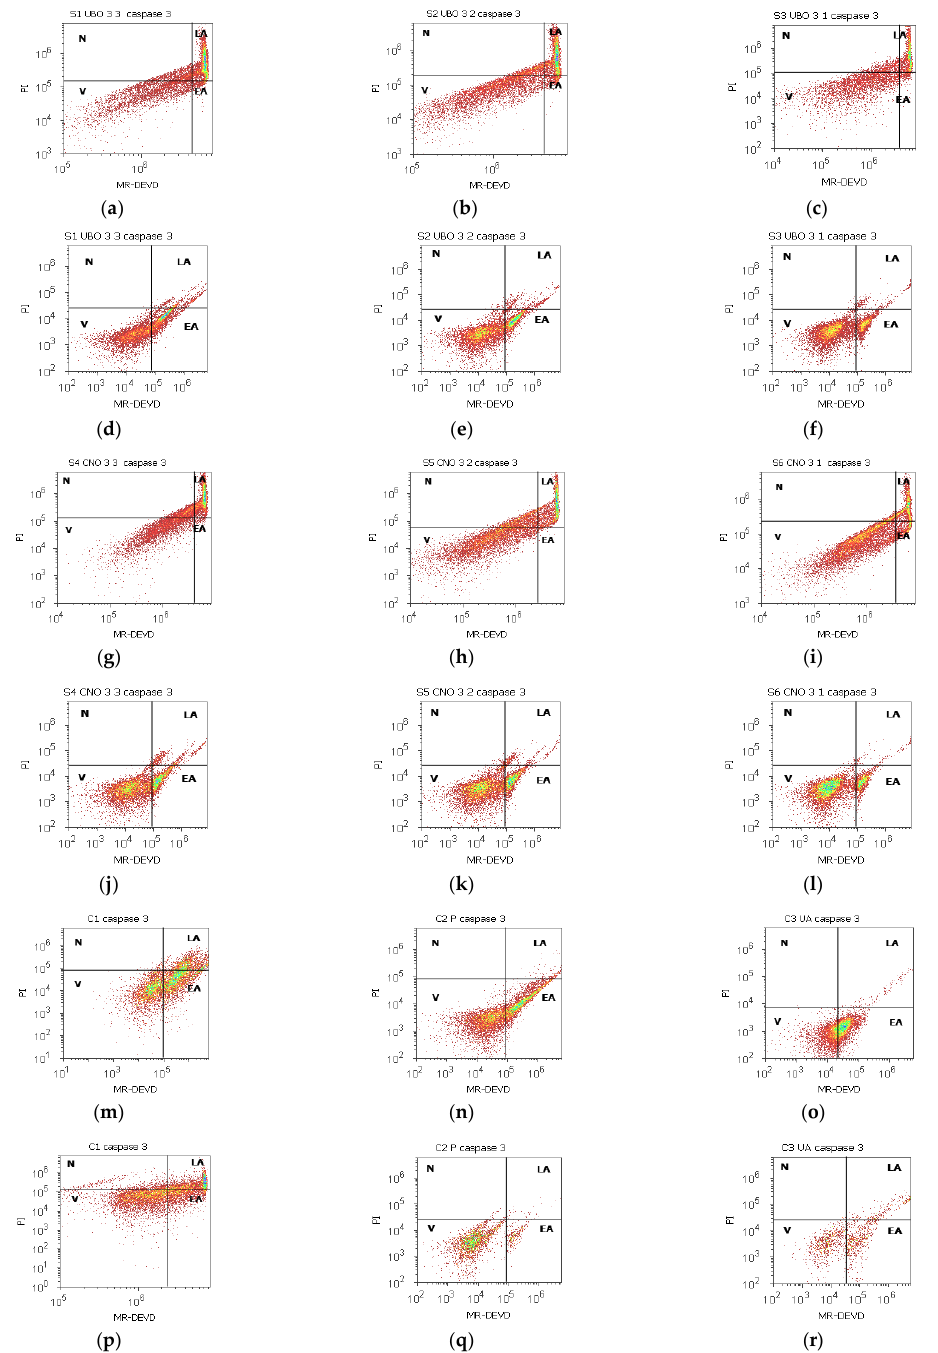
Figure 5. Enzymatic activity of caspase 3/7 in blood cells ( a – c , g – i , m – o ) and CLS-354 tumor cells ( d – f , j – l , p – s ) after 24 h exposure to different concentrations [3:3; 3:2; 3:1] of U. barbata extract in canola oil (UBO) ( a – f ) and canola oil (CNO) ( g – l ) compared to C1, C2P, and C3UA controls ( m – s ). C1 — 1% DMSO (negative control), C2P — 5% Poloxamer 407 (positive control), C3UA — usnic acid (positive control); V — viability; EA — early apoptosis; LA — late apoptosis; N — necrosis. [3:3; 3:2; 3:1] — culture medium/sample ratio ( v/v ).